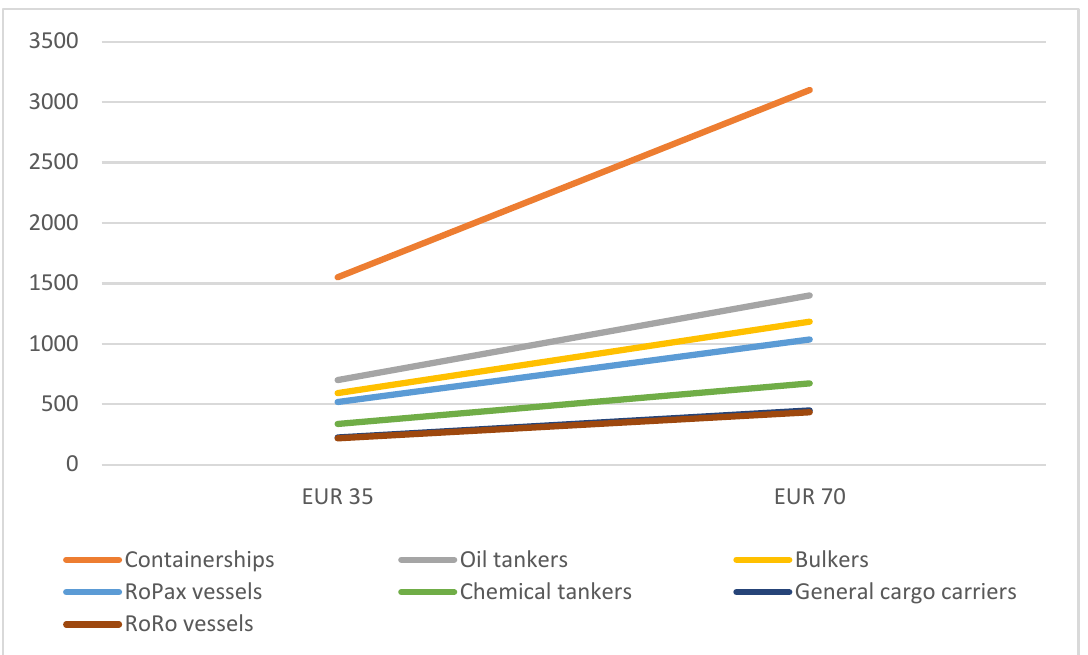
Figure 3. Cost increase per maritime segment assuming the inclusion of all incoming and outgoing voyages from/to an EU port, expressed in MEUR (full auctioning). Source : Created by the authors